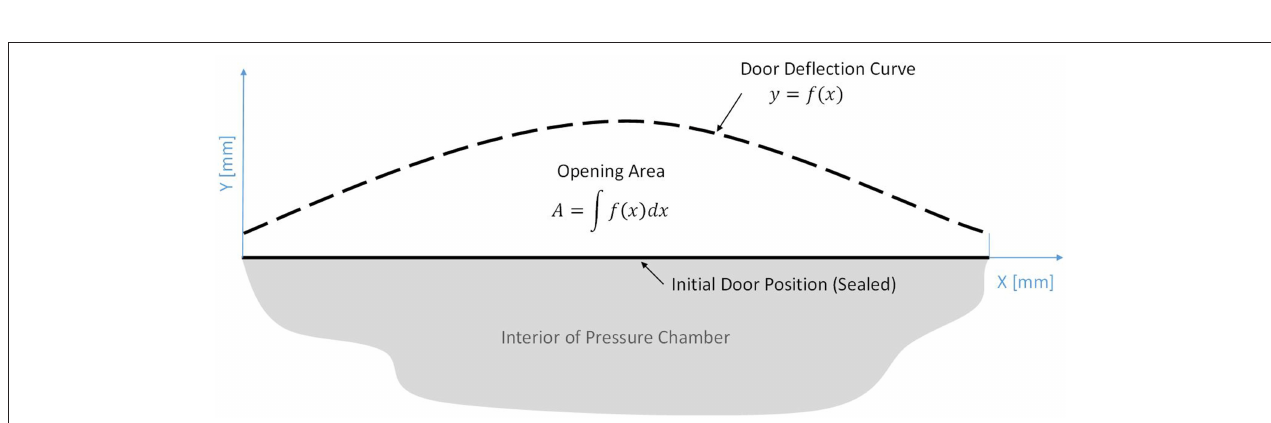
Frontiers in Built Environment |